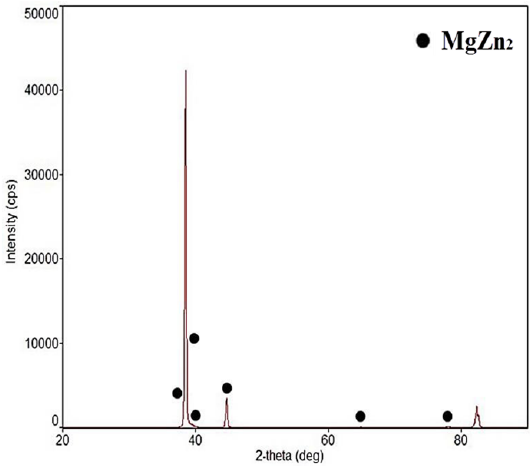
Figure 2: The XRD results of the AA7075 alloy after T6 heat treat-